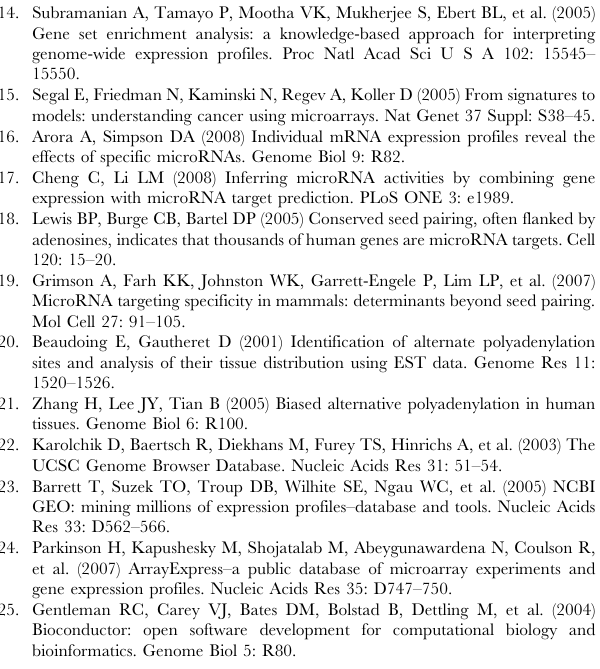
Table S3 MiR-seed activity matrix - Breast cancer